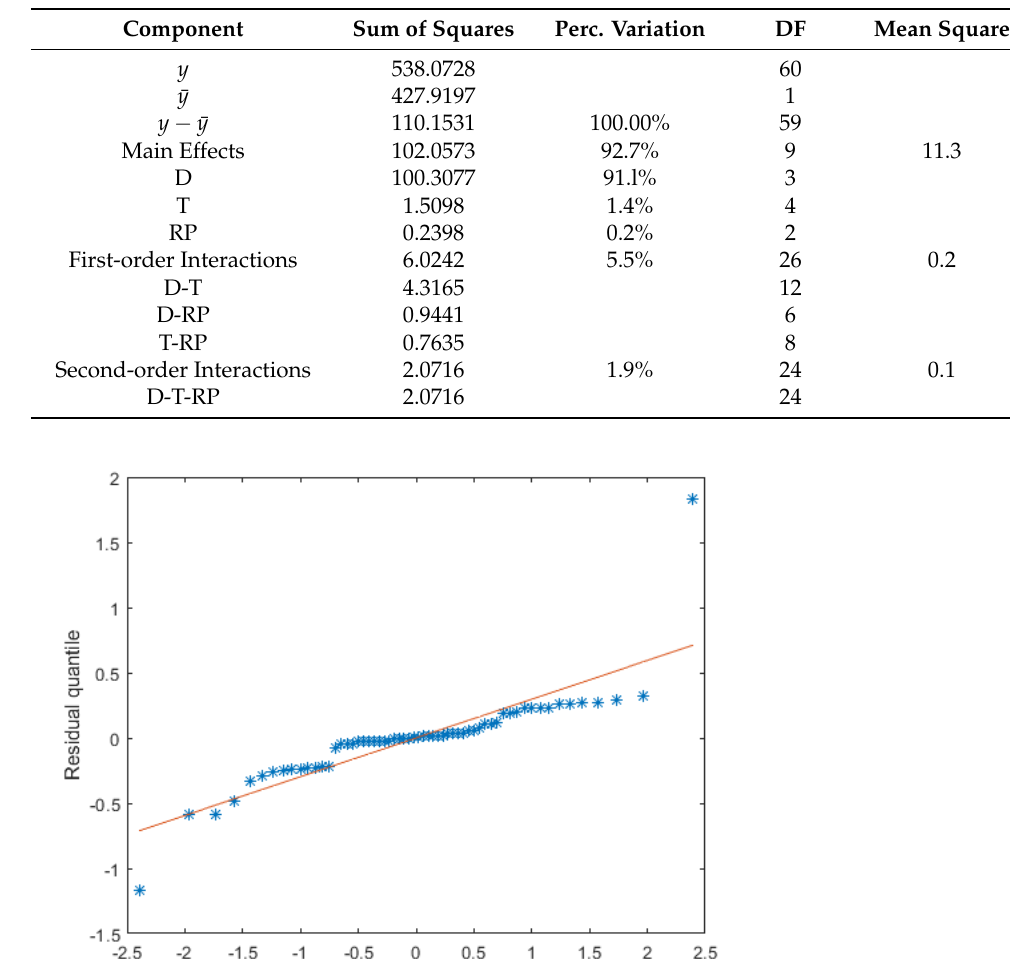
Table 10. ANOVA of latency.